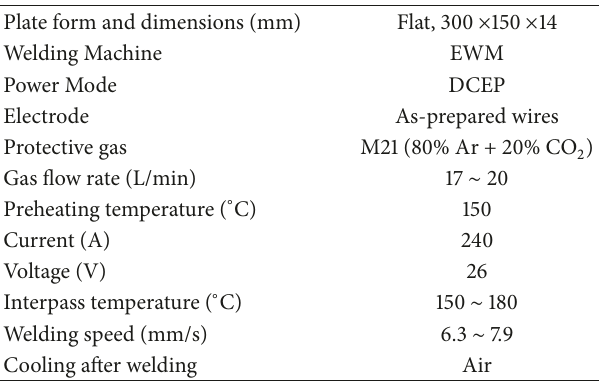
Table 5: Welding parameters for